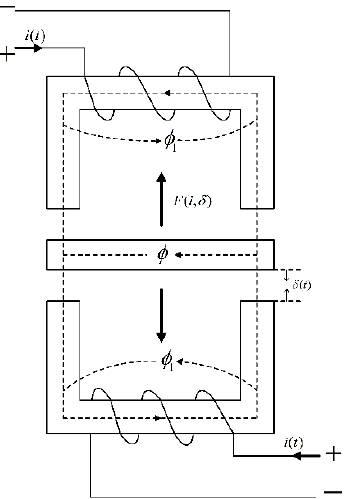
Figure 4. Schematic diagram of the structure of the electromagnetic vibration reduction system.